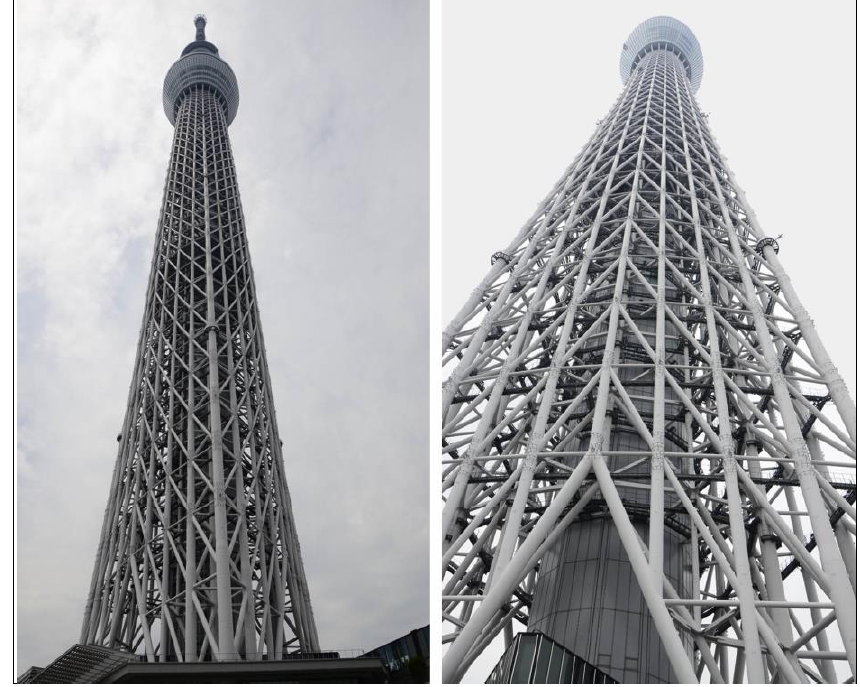
Figure 15. Tokyo Sky tree (photograph by authors).